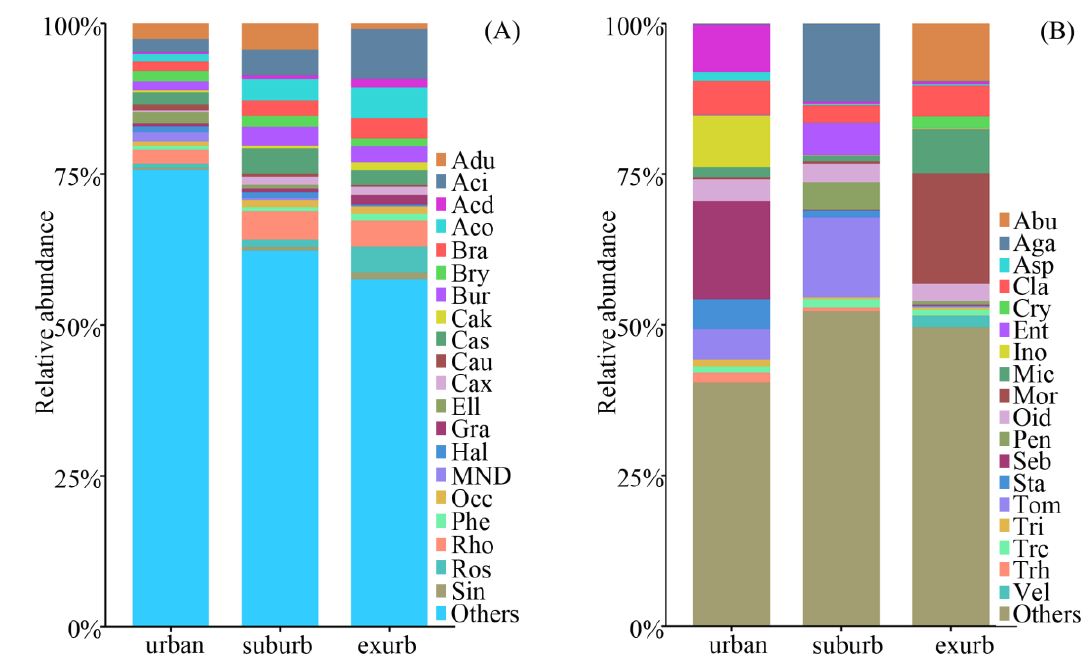
Figure 2. Relative abundance of bacterial genera ( A ) and fungal genera ( B ) along the urban-to-rural gradient at the Dongguan city, southern China. Abbreviations: Aci, Acidibacter